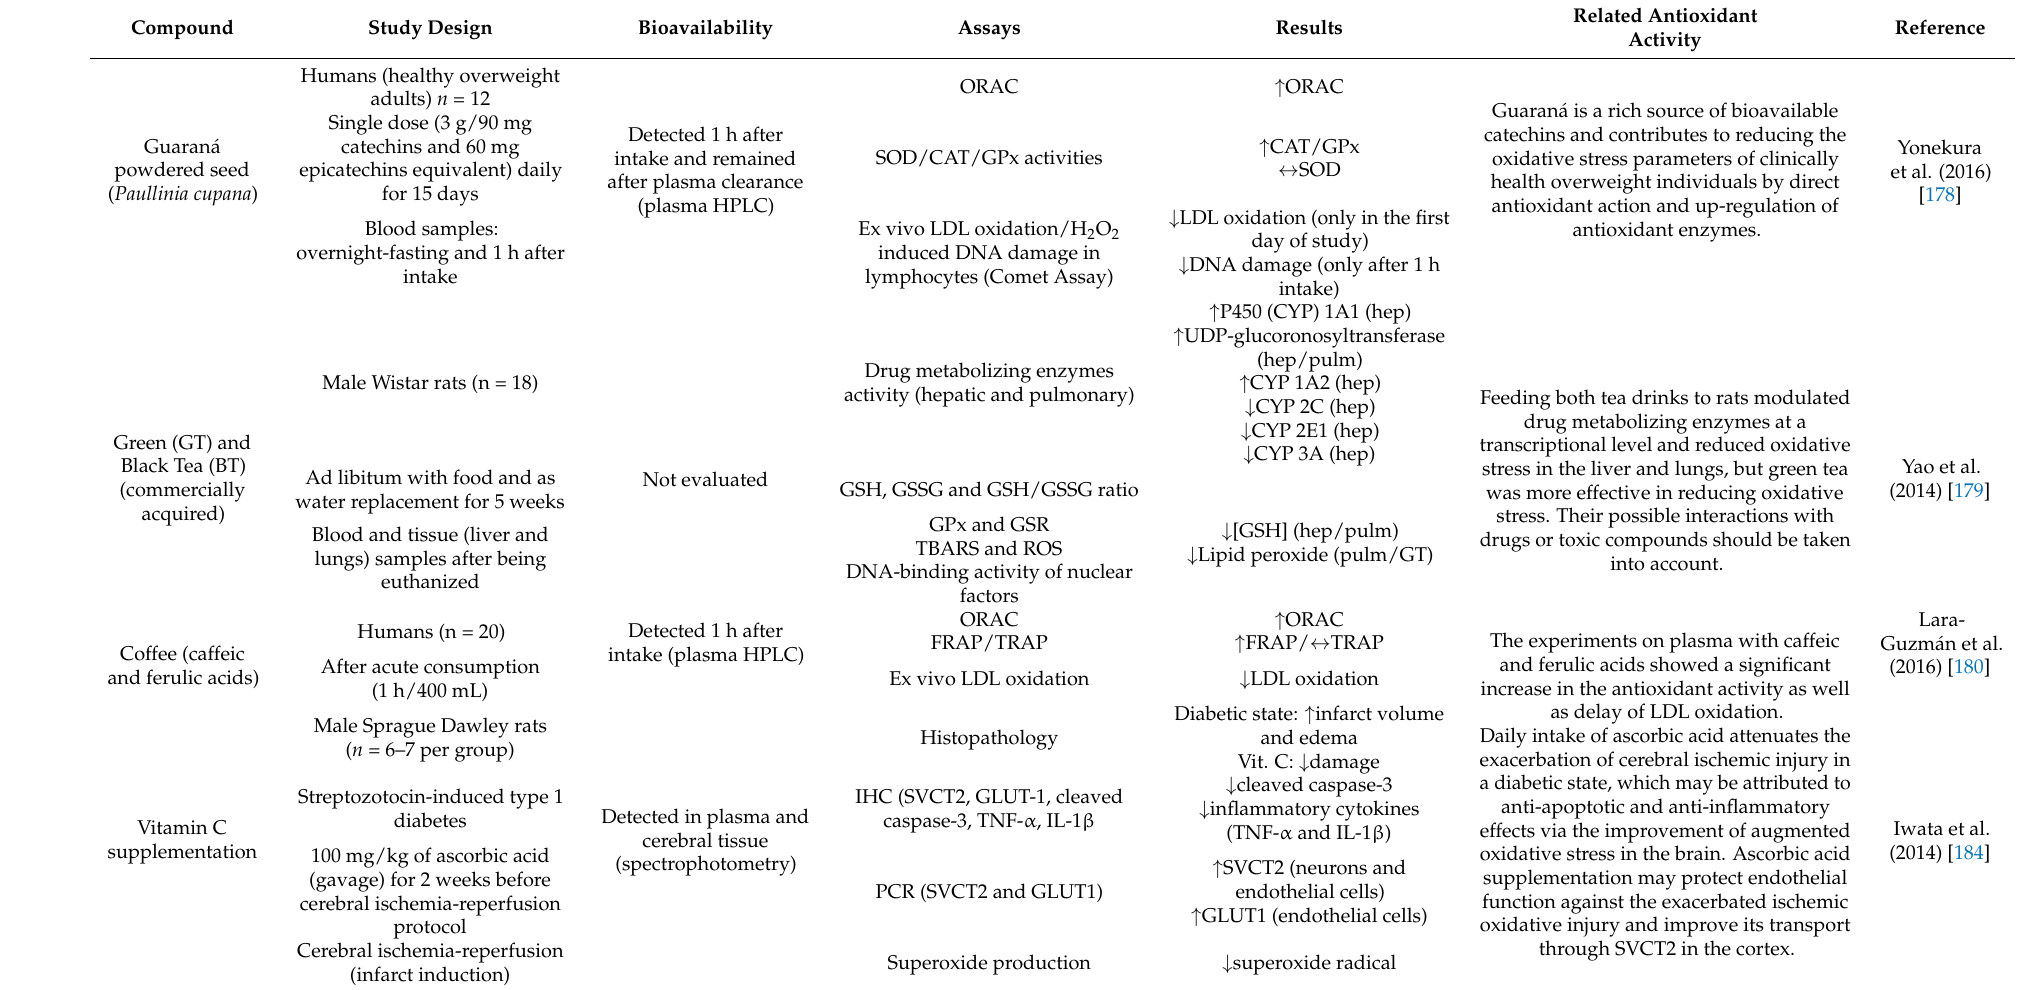
Table 2. Summary of studies on bioavailability and action of polyphenols, vitamins and carotenoids using animal models or clinical